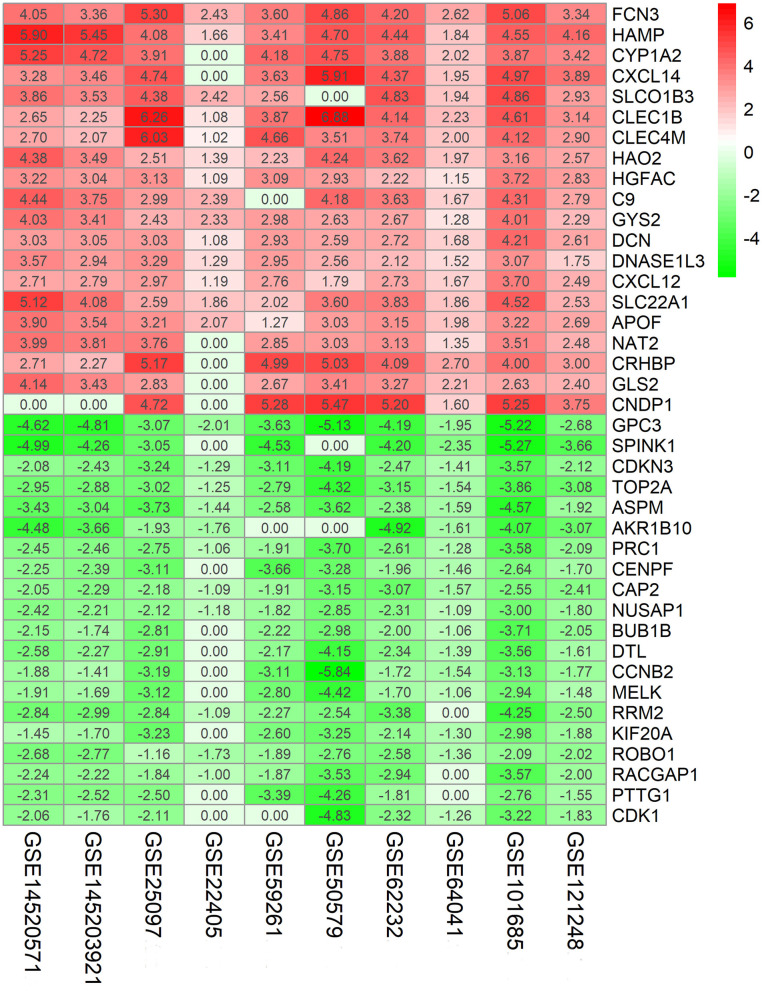
Identification of robust DEGs by RRA method. Heatmap shows the top 20 upregulated and downregulated DEGs in GEO series accessions. Each row denotes one DEG and each column represents one dataset. The color changes from red to green indicates regulation from up to down. The numbers in the box stand for logarithmic fold change.